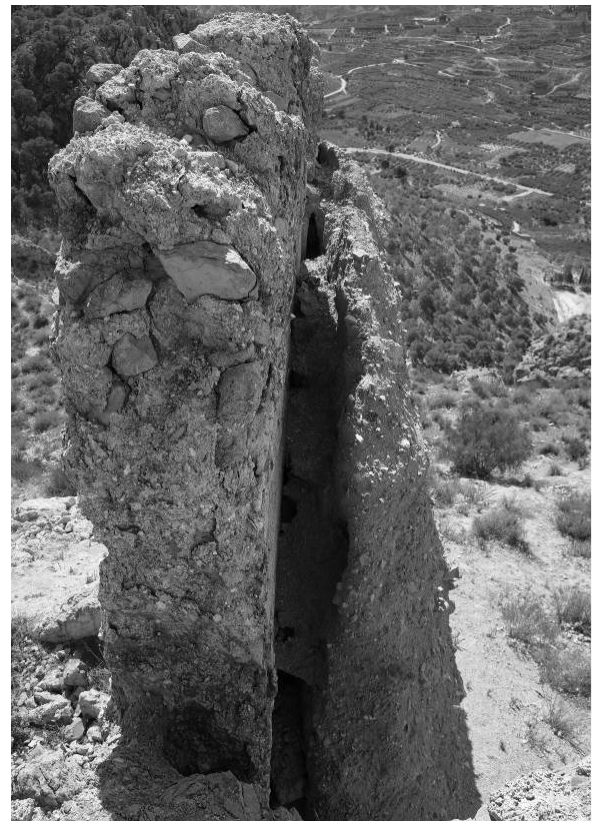
Figure 6. Tower B. Top view of (TC) attached to (ME1).